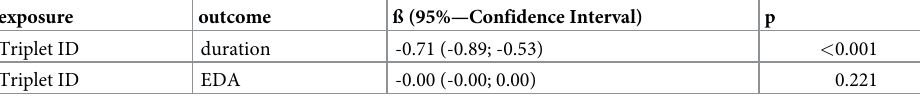
Table 9. Associations of Triplet ID with duration and EDA. Associations were analyzed by mixed models with ran- dom intercept. exposure